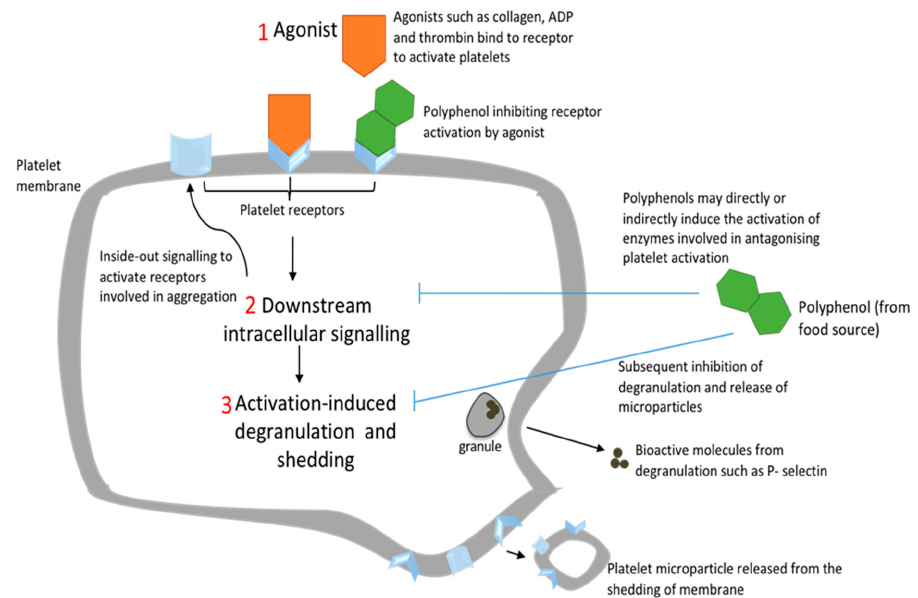
Figure 1. Simplified schematic diagram of proposed inhibitory actions of polyphenols on platelet activation. ( 1) Polyphenols may block receptor–agonist interactions such as P2Y 1 /P2Y 12 –adenosine diphosphate (ADP), glycoprotein VI (GPVI)–collagen, and protease ‐ activated receptor 1 (PAR1)–thrombin. ( 2) Downstream activation signalling is inhibited by the decreased receptor action, scavenging of free radicals, or by polyphenols directly interacting with enzymes such as cyclooxygenease ‐ 1 (COX ‐ 1), phospholipase C (PLC), and protein kinase C (PKC). Decreased intracellular signalling results in decreased Ca 2+ release and expression of receptors such as GPIIa/IIIb necessary for forming platelet aggregates. ( 3) The inhibition of activation by polyphenols results in a reduction in degranulation and platelet microparticle (PMP) release.